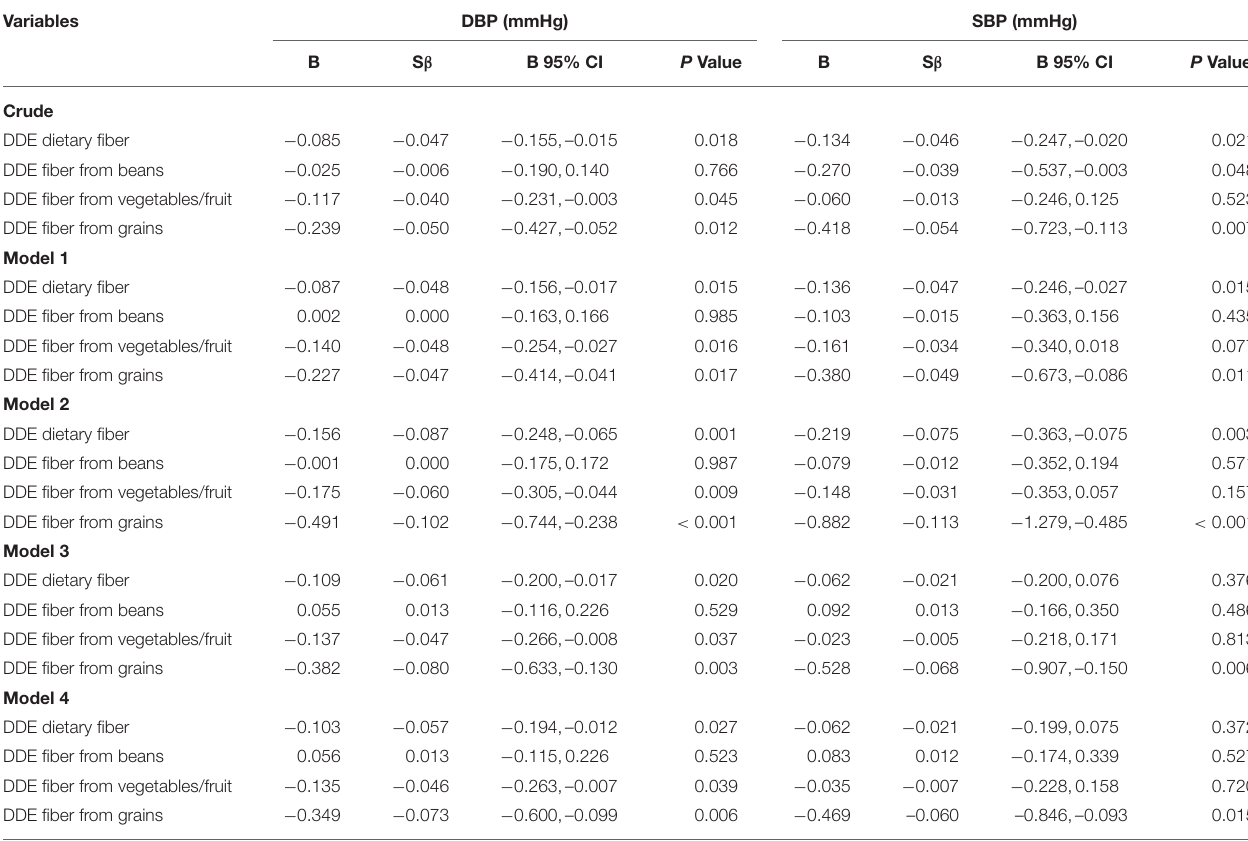
TABLE 2 | Multivariate linear regression on association of DDE fiber and blood pressure.